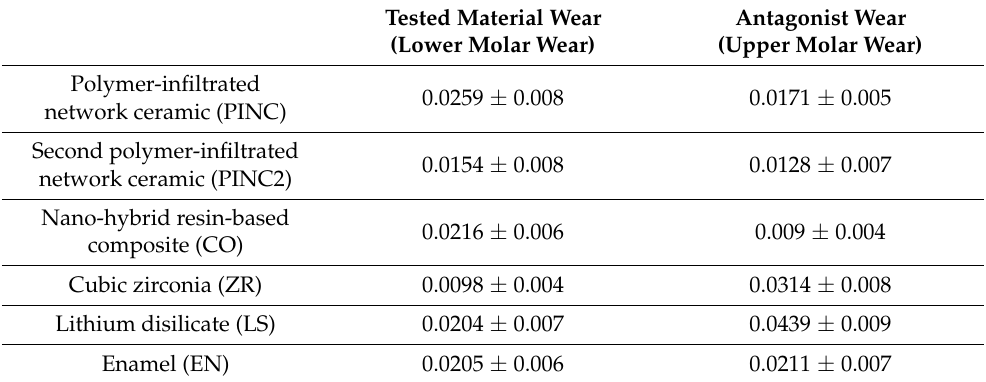
Table 3. Mean ± standard deviation, expressed in mm 3 , for both tested materials and their antagonists. Tested Material